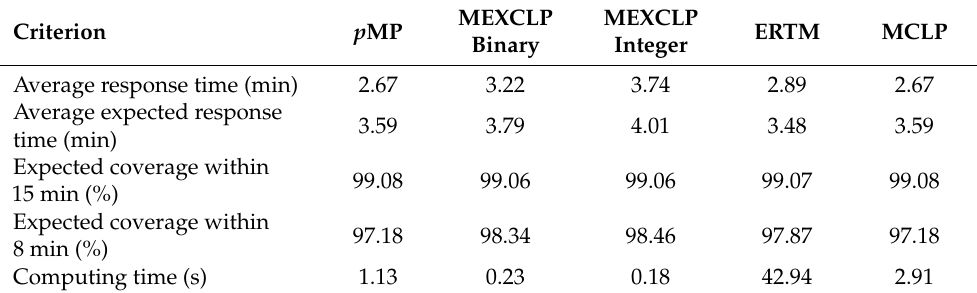
Table 1. Static evaluation of the location models, LandScan model of demand.